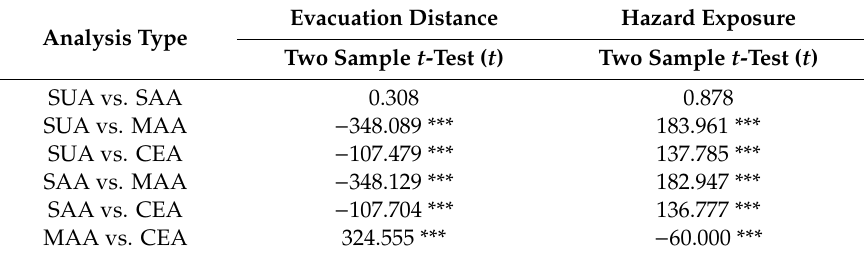
Table 4. Two-sample t -test results for evacuation route analysis.